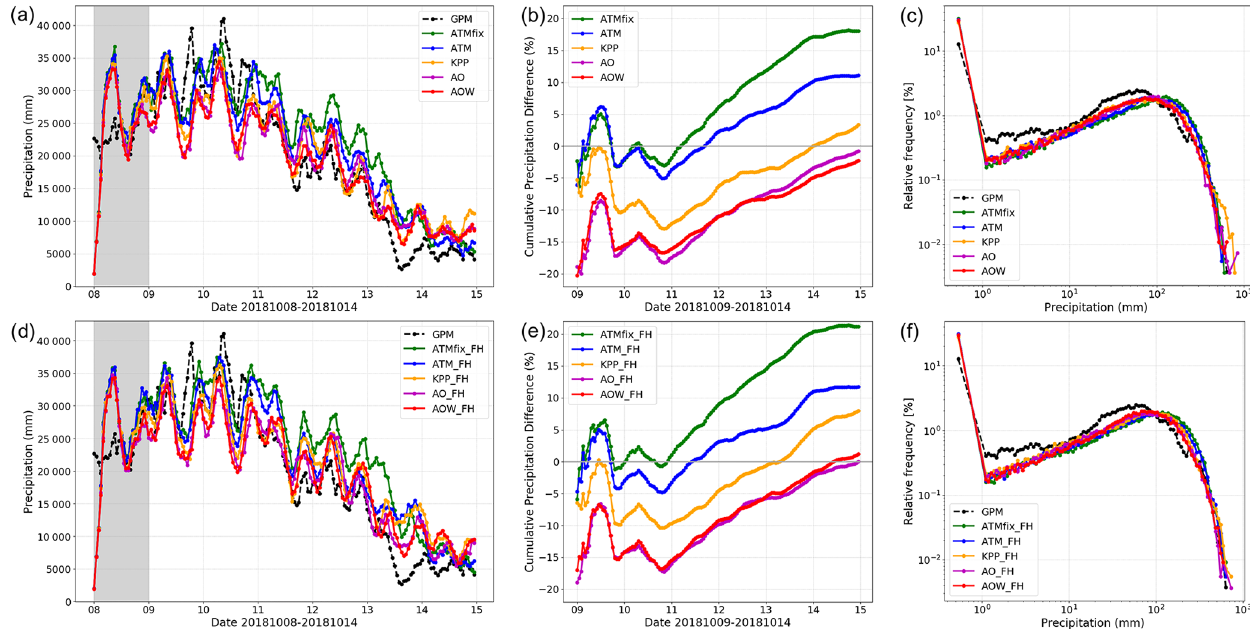
Figure 12. Comparison of Bay of Bengal sub-domain precipitation characteristics for Titli case study for simulations (a–c) without and (d–f) with frictional heating enabled. (a, d) Time series of sub-domain accumulated precipitation for region shown in Fig. 10. (b, e) Cumulative percentage difference between simulated precipitation and GPM observations, computed after day 1 of simulation to avoid spin-up effects. (c, f) Frequency distribution of 7d accumulated precipitation relative to GPM.